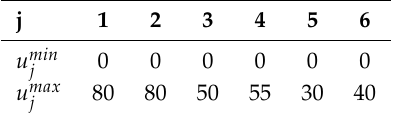
Figure 1 and Table 3 characterize the behaviour of error term D n = (cid:107) u n + 1 − u n (cid:107) ≤ TOL regarding Algorithm 1 ( Algo1 ) with respect to different values of ϑ n in terms of the number of iterations and elapsed time,